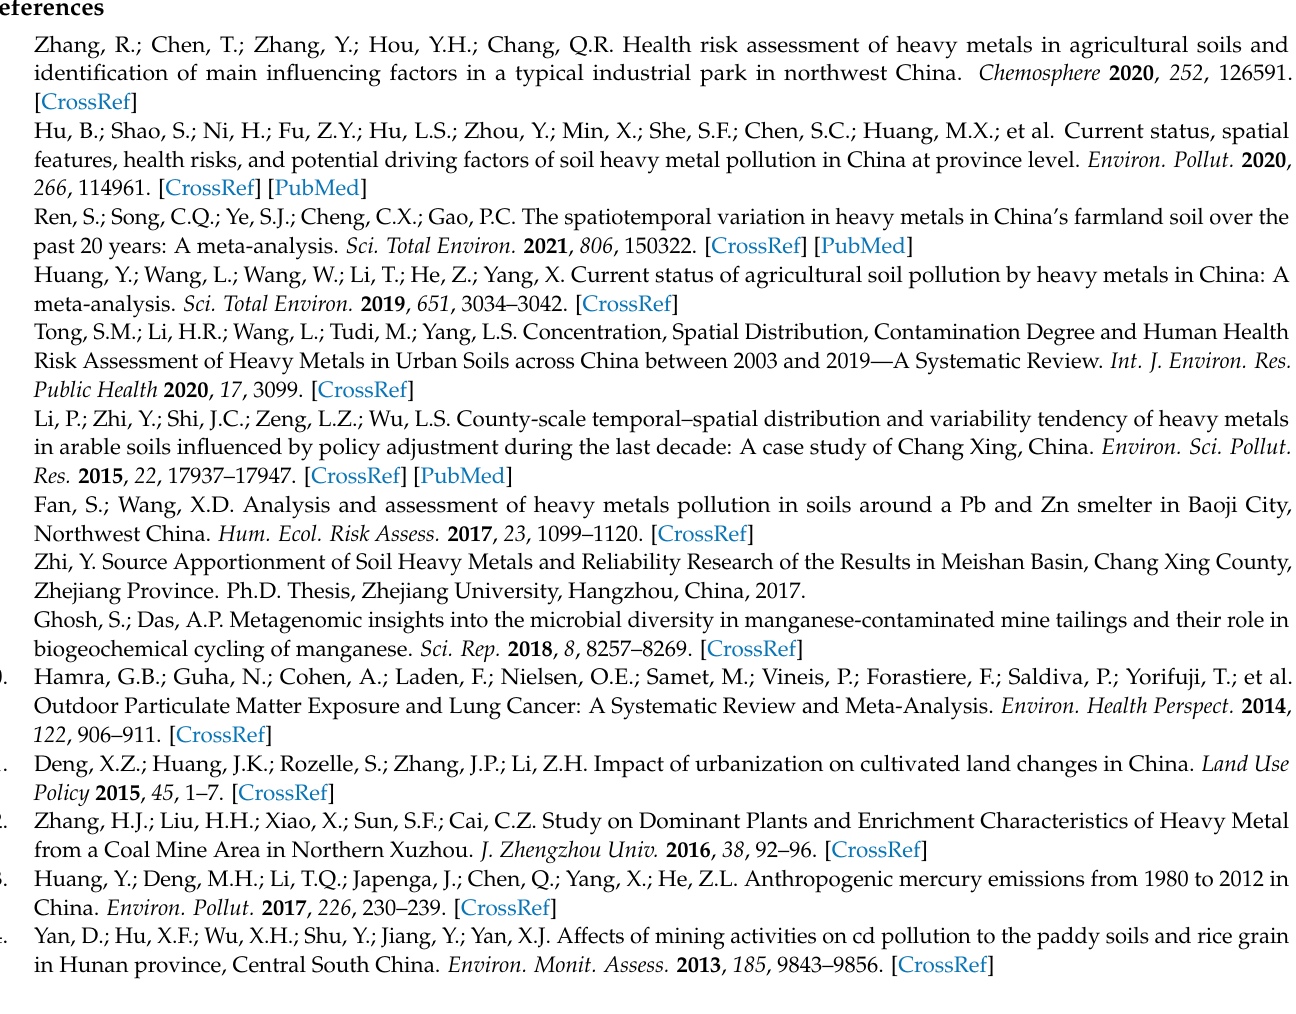
analysis. Figure S2: The annual subgroup analysis of the ecological risk index. Table S1: The Shapiro- Wilk test of weights and mean concentrations. Table S2: The weighted mean values (mg/kg) of heavy metals calculated by the four datasets. Table S3: The risk control standard for the environmental quality of other countries (mg/kg). Table S4: Concentration projections in optimistic scenario. Table S5: Concentration projections in no-mutation scenario. References [86–92] are cited in the supplementary